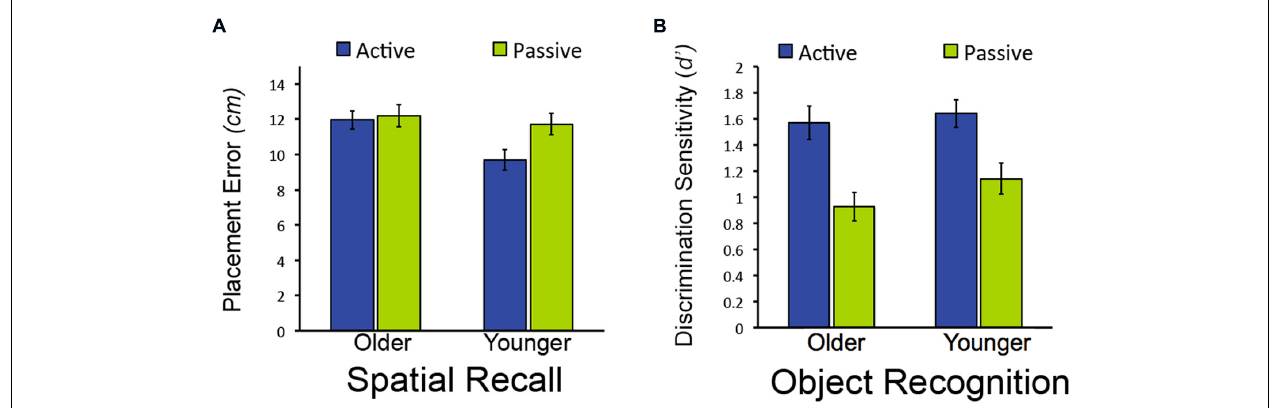
FIGURE 2 | Effects of age on object-location recall but not object recognition in Experiment 1. (A) Mean placement error for object-location recall in Experiment 1. (B) Mean performance (discrimination sensitivity) for object recognition in Experiment 1. Note